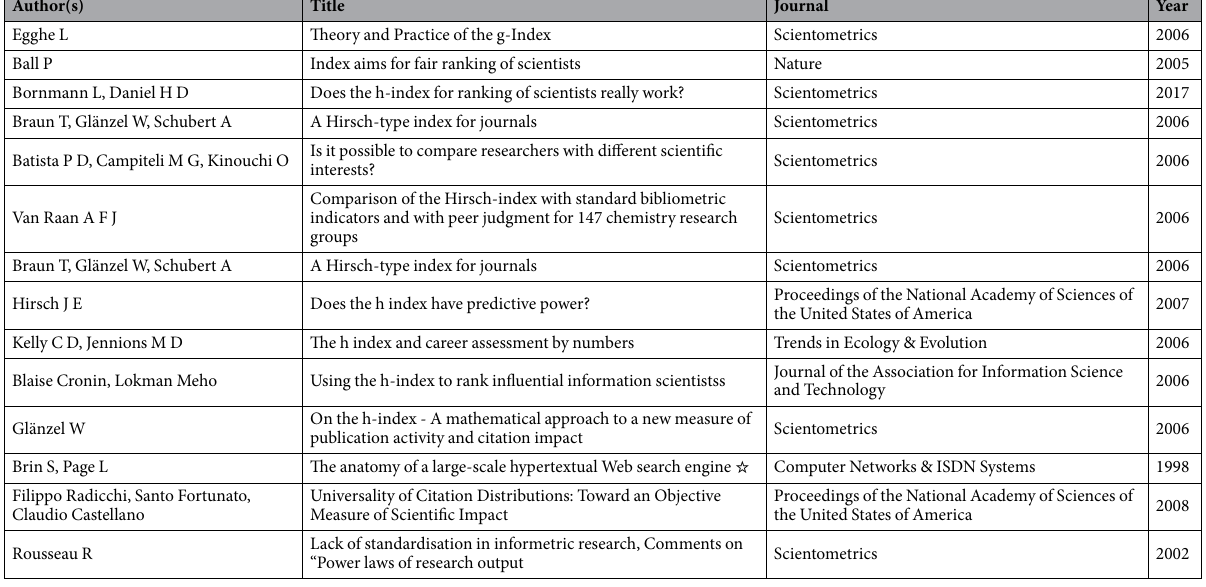
Table 2. All h -backbone in the co-citation